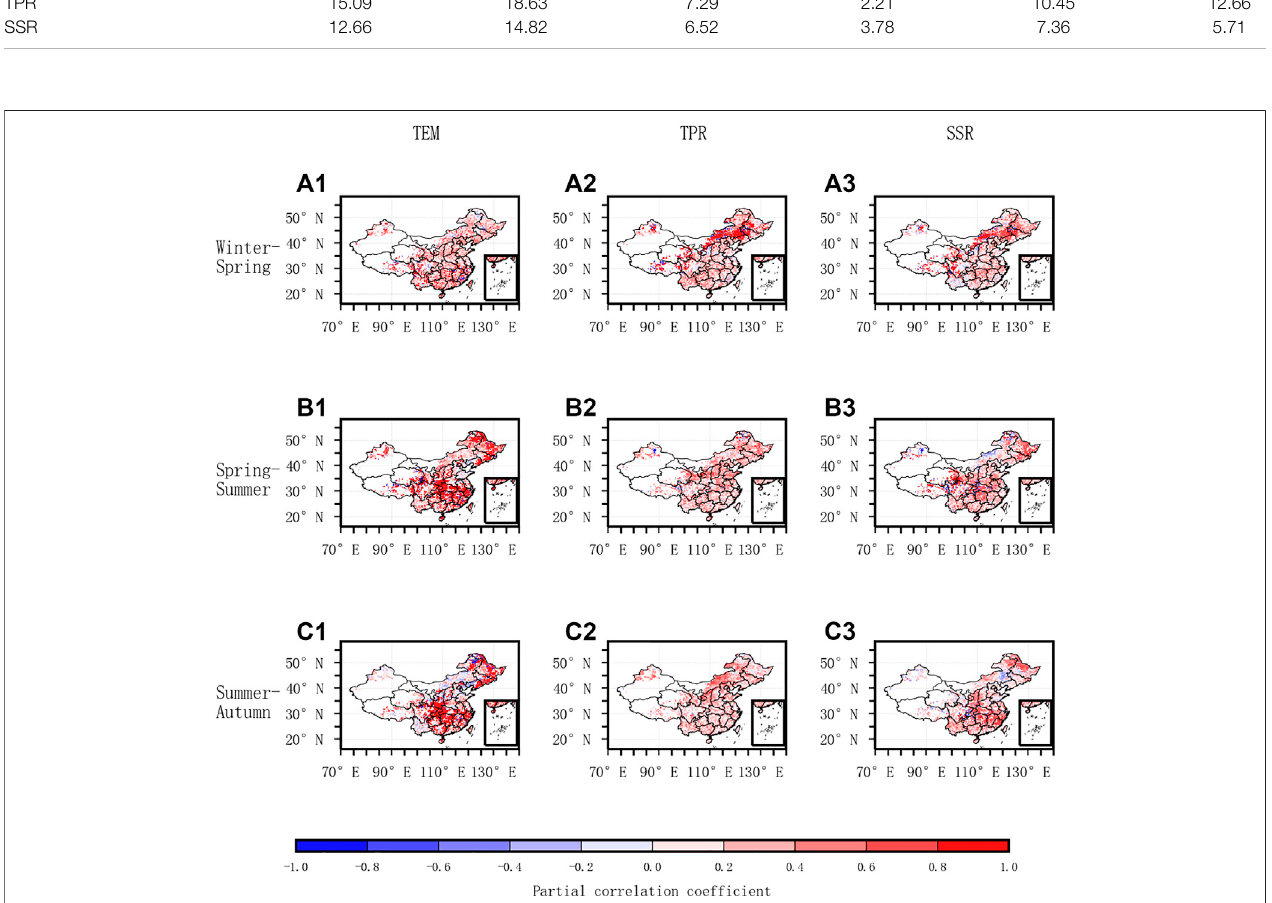
FIGURE 4 | Partial correlation coef fi cient between vegetation coverage and meteorological elements (TEM, TPR, and SSR) of the previous seasons, the absolute value of the partial correlation coef fi cient ≥ 0.455; it passes the 95 % signi fi cance test.